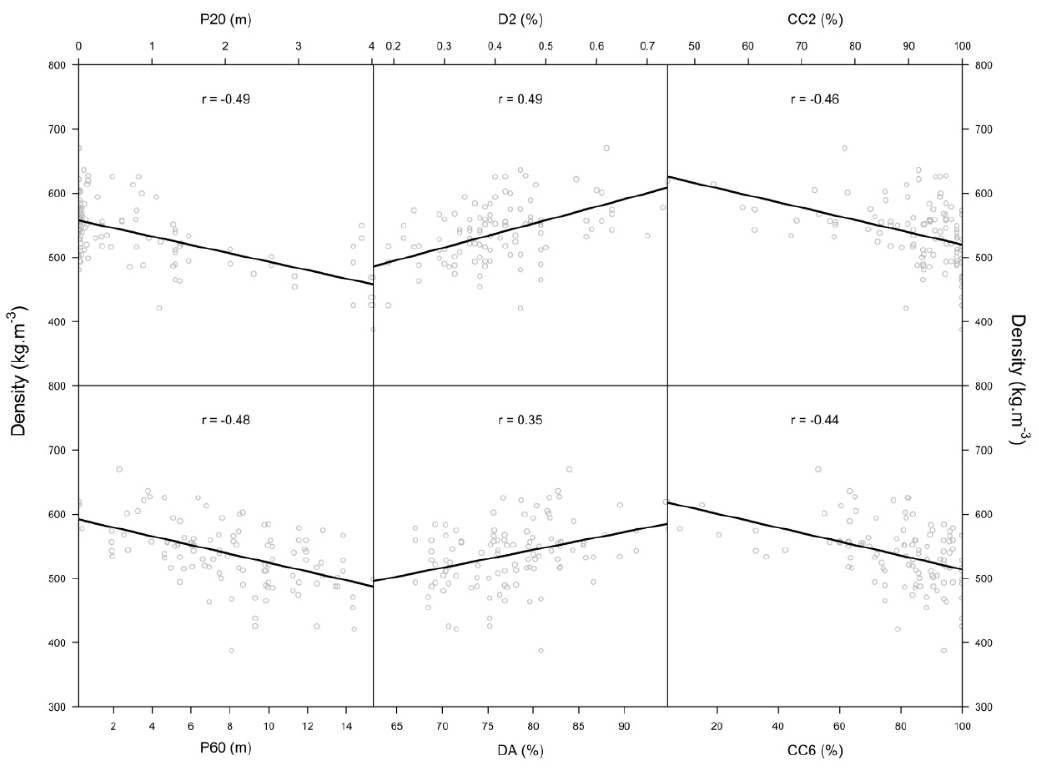
Figure 2. Correlation (Spearman) between selected predictor variables and wood density.